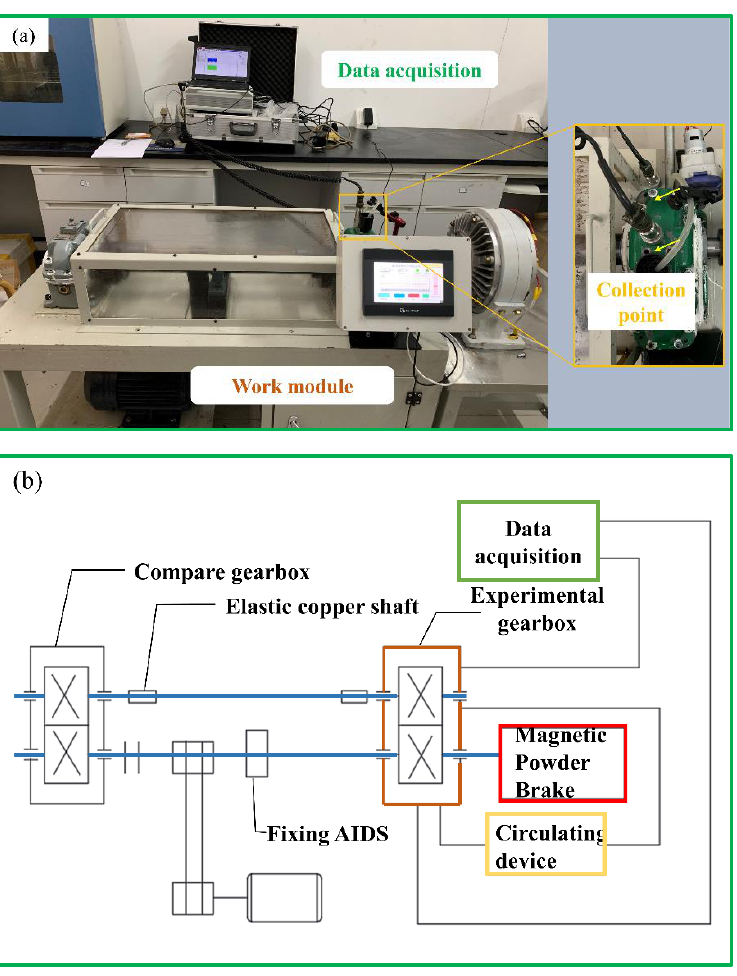
Figure 3. Gear test bench; ( a ) data integration gear test bench, ( b ) composition and structure diagram of test bench.